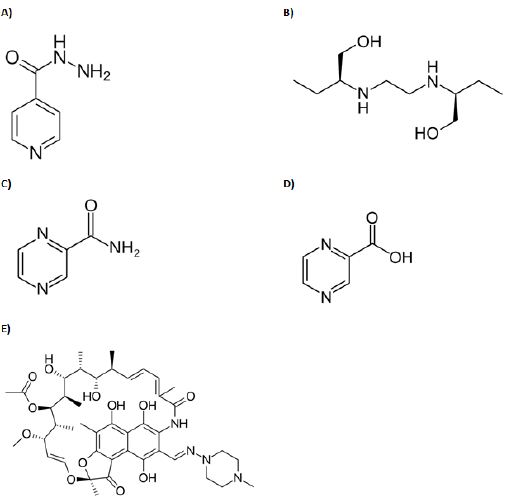
Figure 1. Structures of anti ‐ tuberculous drugs reviewed in this manuscript: ( A ) Isoniazid, ( B ) Eth ‐ ambutol, ( C ) Pyrazinamide, ( D ) Pyrazinoic acid, ( E )